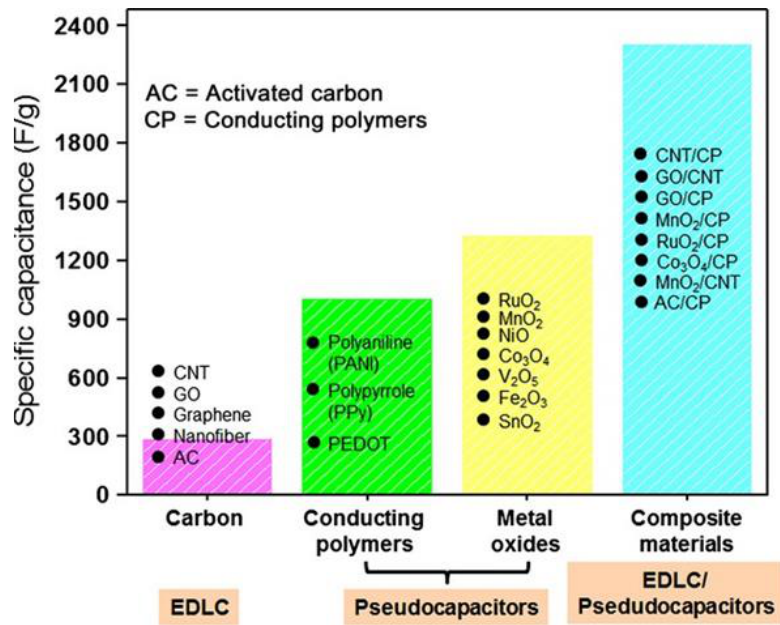
Figure 5. Comparison of various materials according to their specific parameter for supercapacitor application. Reproduced with permission from [7] (Shown et al.). application. Reproduced with permission from [7] (Shown et